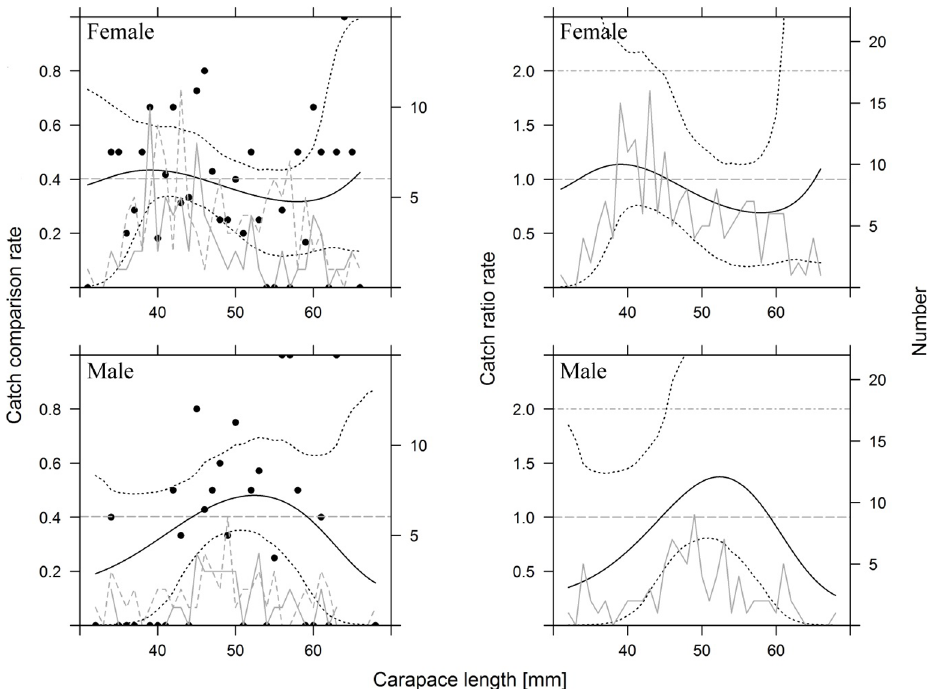
Fig. 3. Catch comparison rates (left column) and catch ratio rates (right column) for the longline deployments with one and two days soaking time (solid black curves) for females and males of Norway lobster. Dots represent the experimental rates. Thin black dotted curves represent the 95% CI for the catch comparison curves. Dark grey solid curves (left column) represent summed and raised catch populations for deployments with two day soaking time. Dark grey dashed curves (left column) represent summed and raised catch population for deployments with one day soaking time. Dark grey dashed curves (right column) represent total summed and raised catch population for one and two day soaking time. Horizontal dark grey dashed lines represent baselines for no effect of soaking time on the catch performance. Horizontal dark grey dot-dashed line represents line where longlines soaked for two days are catching twice as much as longlines soaked for one day. Female: Norway lobster females; male: Norway lobster